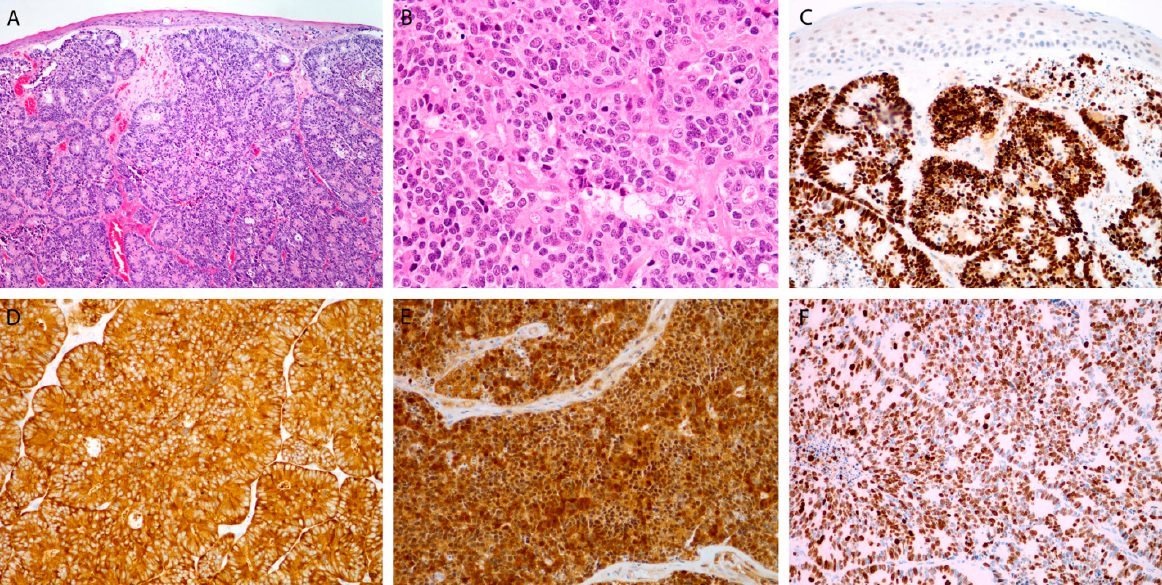
Figure 2. Large cell poorly differentiated neuroendocrine carcinoma. Tumor islands be-neath the surface epithelium, with rosette formation, composed of larger cells, with many mitoses ( A and B ). Immunohistochemical staining for INSM1 ( C ), synaptophysin ( D ), p16 ( E ), and Ki-67 ( F ). Magnification 10 × 10 (A and C), 10 × 20 (B, D–F).